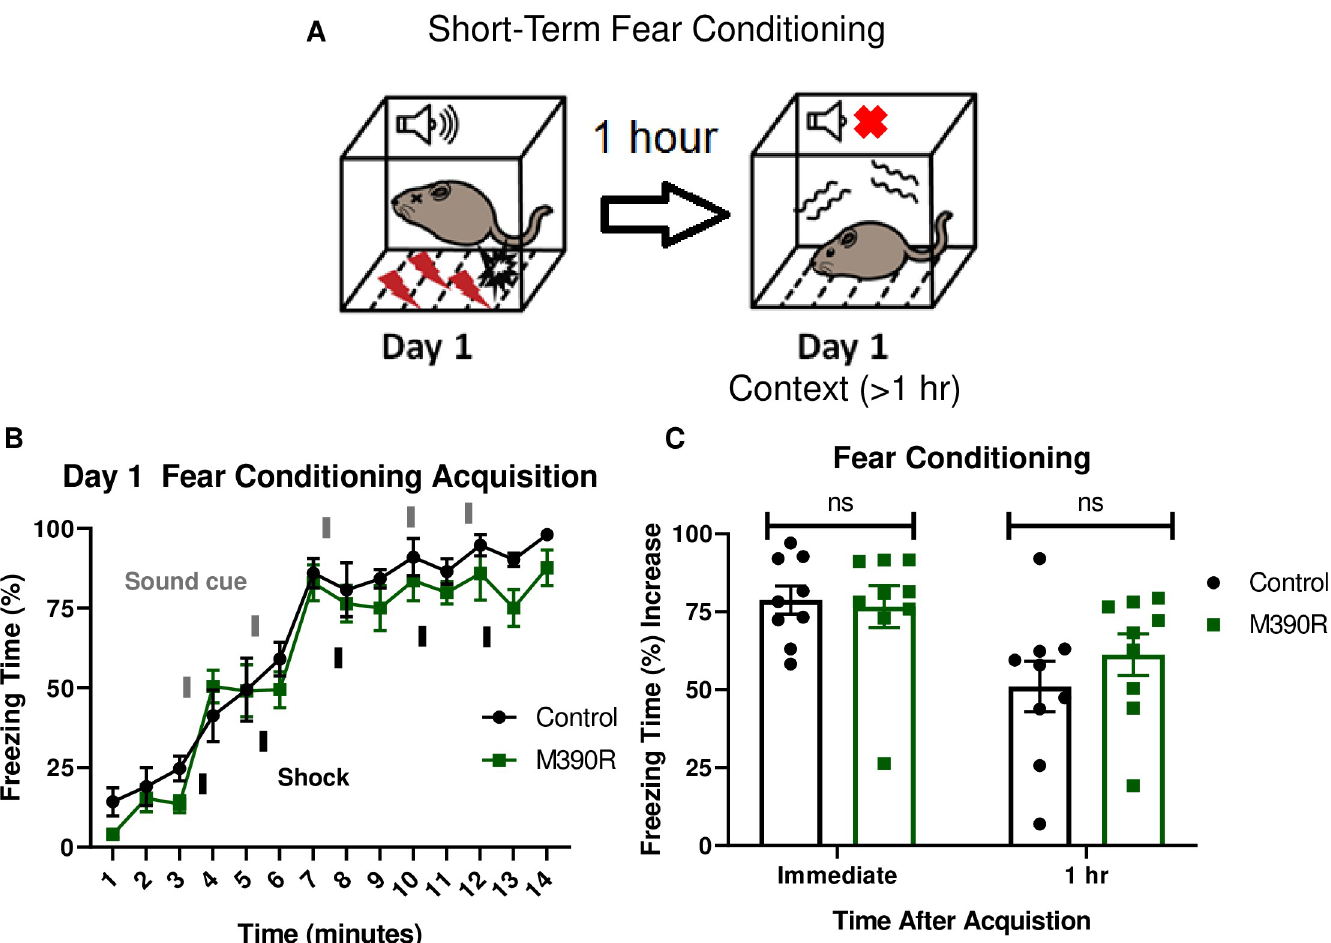
Fig 2. Bbs1 M390R/M390R mice have normal short-term context fear conditioning. A.) Schematic diagram of the one day delay fear conditioning procedure. On the first day, a mouse is placed in a chamber, and a sound is paired with a shock multiple times. One hour later, the mouse is placed back in the chamber, and freezing is measured for short-term context fear conditioning. B.) Day 1 acquisition between the control mice (n = 9) and the Bbs1 M390R/M390R mice (n = 9) used for the short-term fear conditioning differed significantly (2-way ANOVA, time X genotype, F (13, 224) = 0.5574, P = 0.8858, time, F (13, 224) = 56.19, P < 0.0001, genotype, F (1, 224) = 9.369, P = 0.0025). The thick lines above the curve indicate when the sound cue was given, and the thick lines below the curve indicate when the shock was given. C.) The immediate fear conditioning indicates training to the day 1 fear conditioning. The immediate fear conditioning is measured as the difference of the freezing